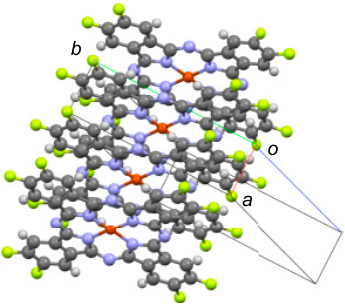
Figure 2. One-dimensional molecular arrangement of F 8 CuPc along the a -axis.